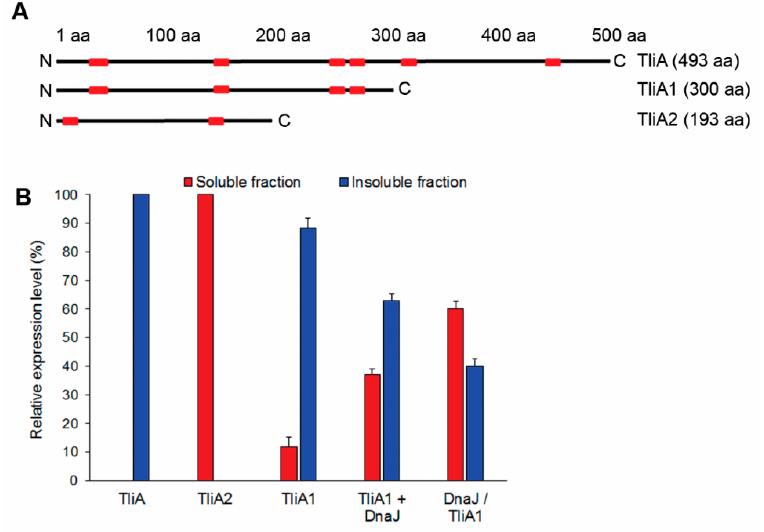
Figure 6. Size-dependent recombinant protein solubilization using the CLEX system. ( A ) Distribution of DnaJ and DnaK binding sequences on the lipase TliA is shown by the red rectangle positions. Binding sites were predicted using a Limbo chaperone binding site predictor [38]. ( B ) TliA1 fragment solubilization using the CLEX system. TliA1 + DnaJ indicates non-coupled co-overexpression, whereas DnaJ/TliA1 represents the CLEX system with DnaJ used as the first cistron. Relative expression was measured by SDS-PAGE and qualified using ImageJ v1.48 software. Error bars in ( B ) indicate ± S.D. from three independent experiments.